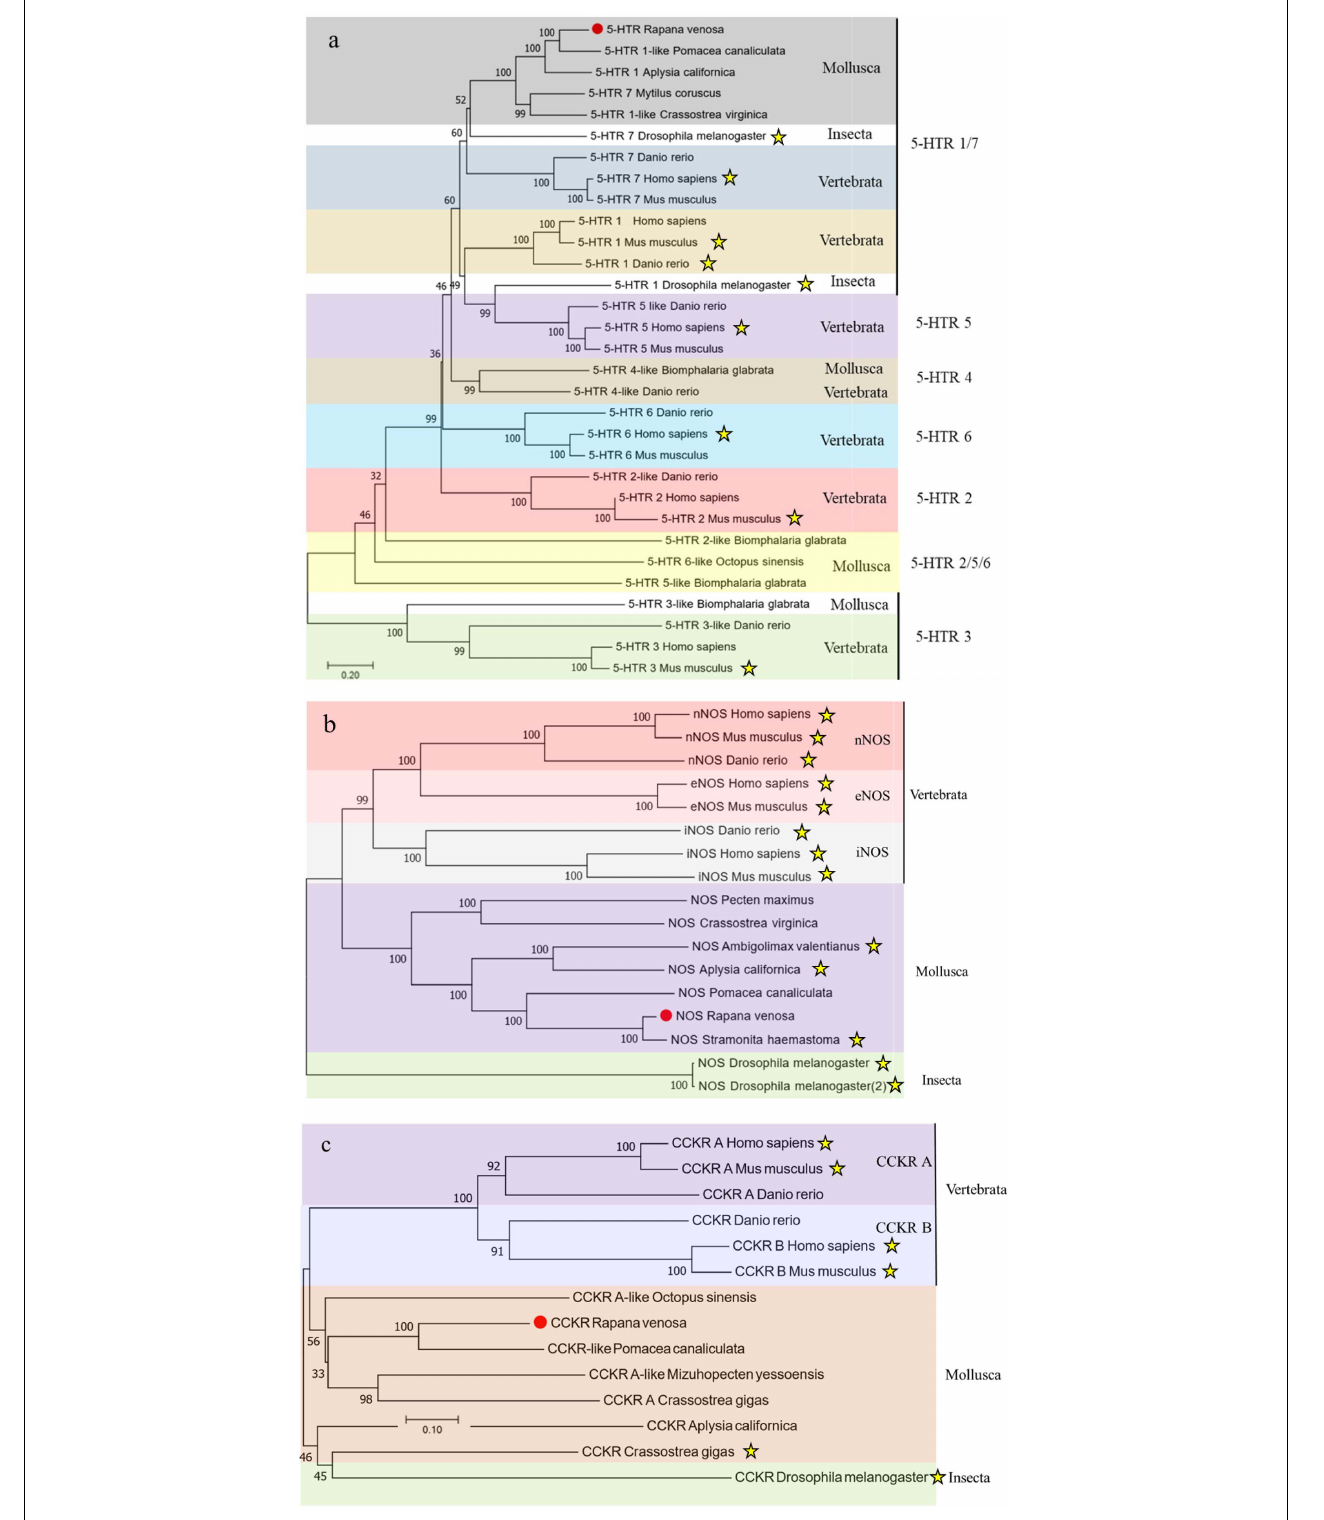
FIGURE 2 | Phylogenetic trees based on Rv-5HTR (a) , Rv-NOS (b) , and Rv-CCKR (c) deduced amino acid sequences from Rapana venosa and other species. The trees were constructed based on the multiple sequence generated by Clustal X and aligned using the neighbor-joining method in MEGA 7.0. The genes which have been pharmacologically proven were highlighted with asterisk, which has been listed in Supplementary Table 3 .